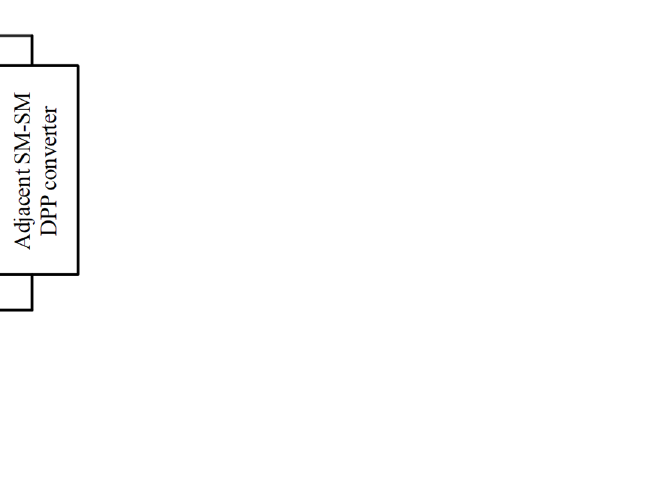
Figure 3. General structure of submodule-to-submodule ( SM - SM ) mismatch mitigation DPP converter.